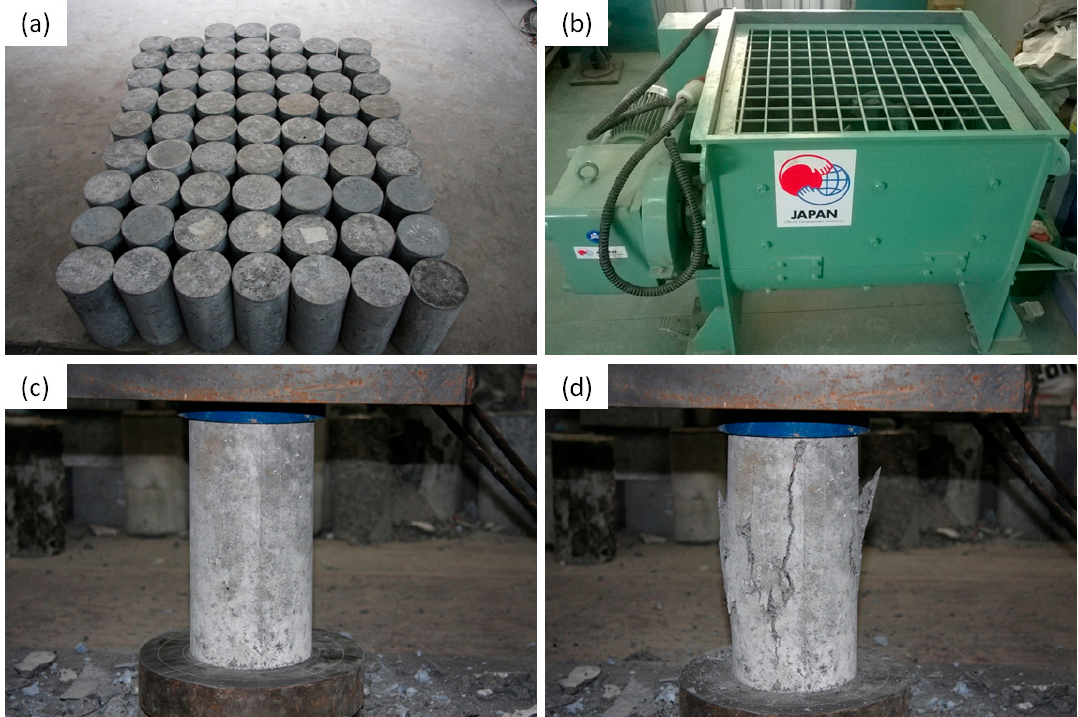
Figure 4. ( a ) Samples of geopolymer concrete (GPC) using steel slag aggregate; ( b ) forced mixing concrete mixer; ( c ) compressive strength test of the specimen; ( d ) fracture mode.